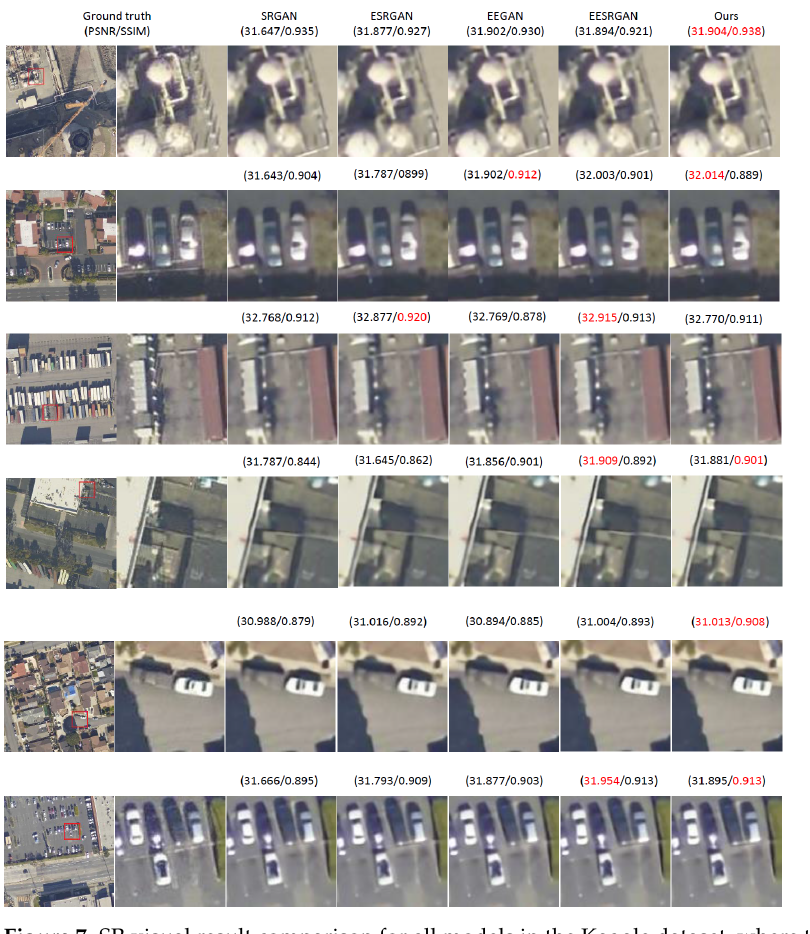
Figure 7. SR visual result comparison for all models in the Kaggle dataset, where the best results are shown in red font.